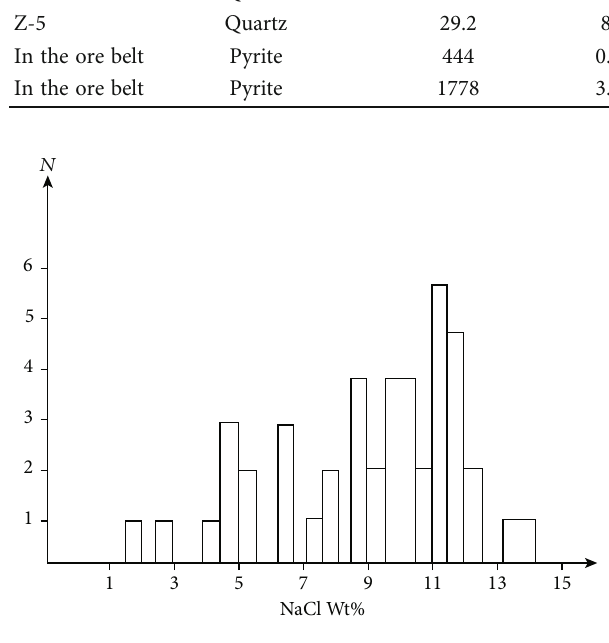
Figure 3: Salinities in Zhacun